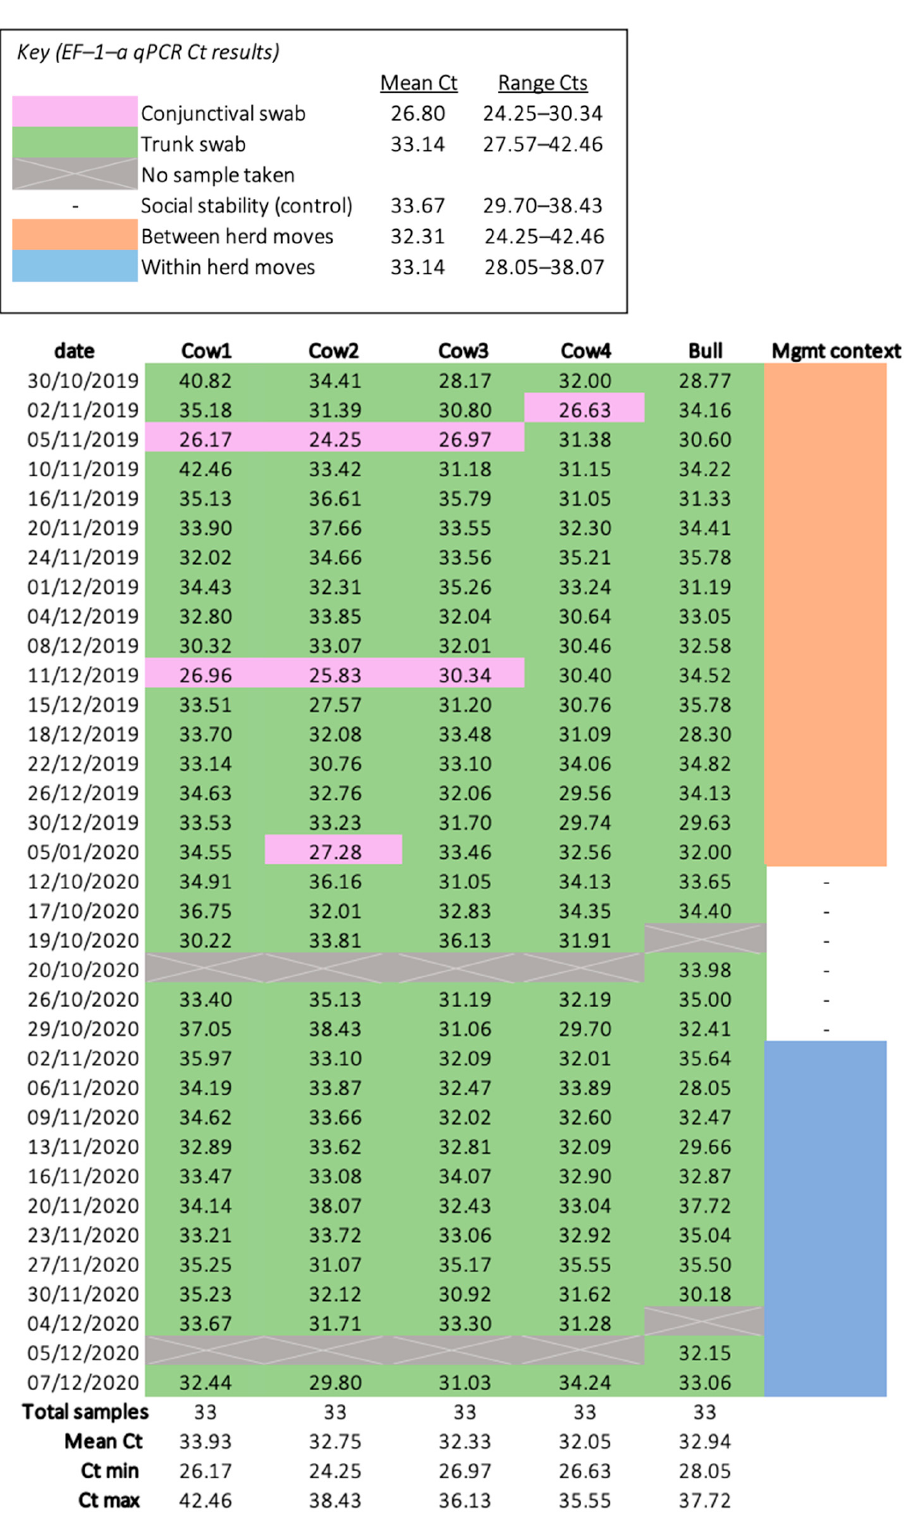
Figure 2. Heatmap of the housekeeping gene (EF–1– α ) qPCR results. All samples had a detectable level of EF–1– α and, therefore, no samples were excluded from statistical analyses.